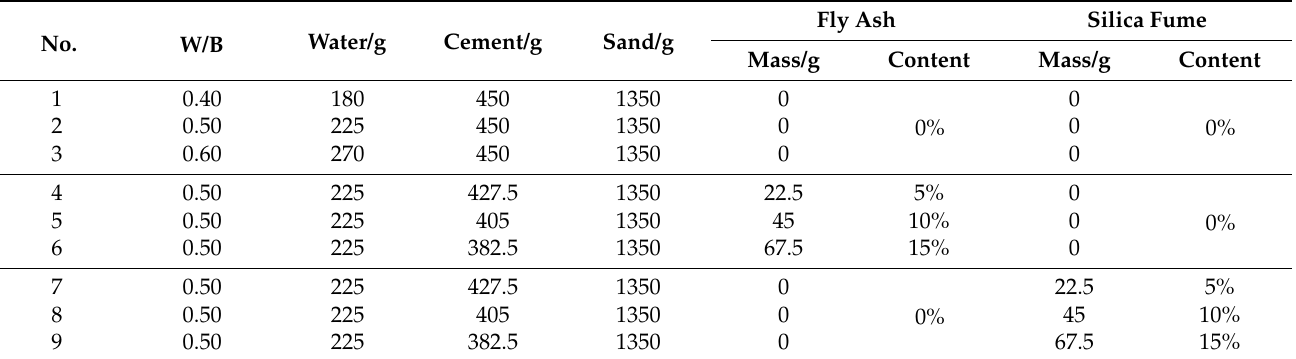
Table 6. Mix ratio